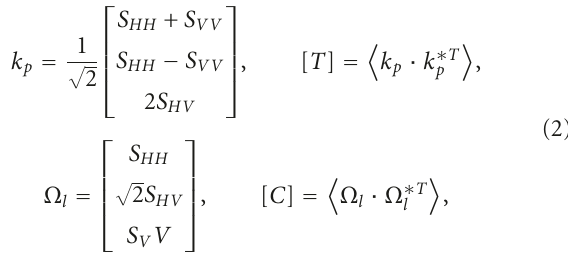
phase di ff erence, copolarized ratio in dB, cross-polarized ratio in dB, ratio HV/VV in dB, copolarization ratio, and depolarization ratio